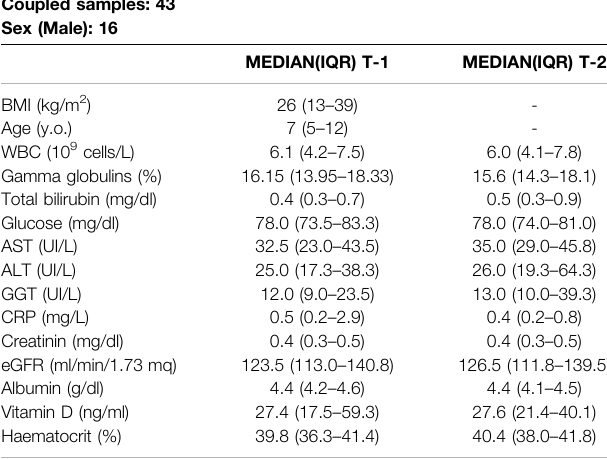
TABLE 1 | Summary of patients ’ characteristics at the two considered timings. Bodymassindex(BMI),whiteblood cells(WBC),aspartateamino-transferase (AST), alanin amino transferase (ALT), gamma glutamil transferase (GGT), C-reactive protein (CRP), calculated glomerular fi ltration rate (eGFR) Number of patients: 27 Coupled samples: